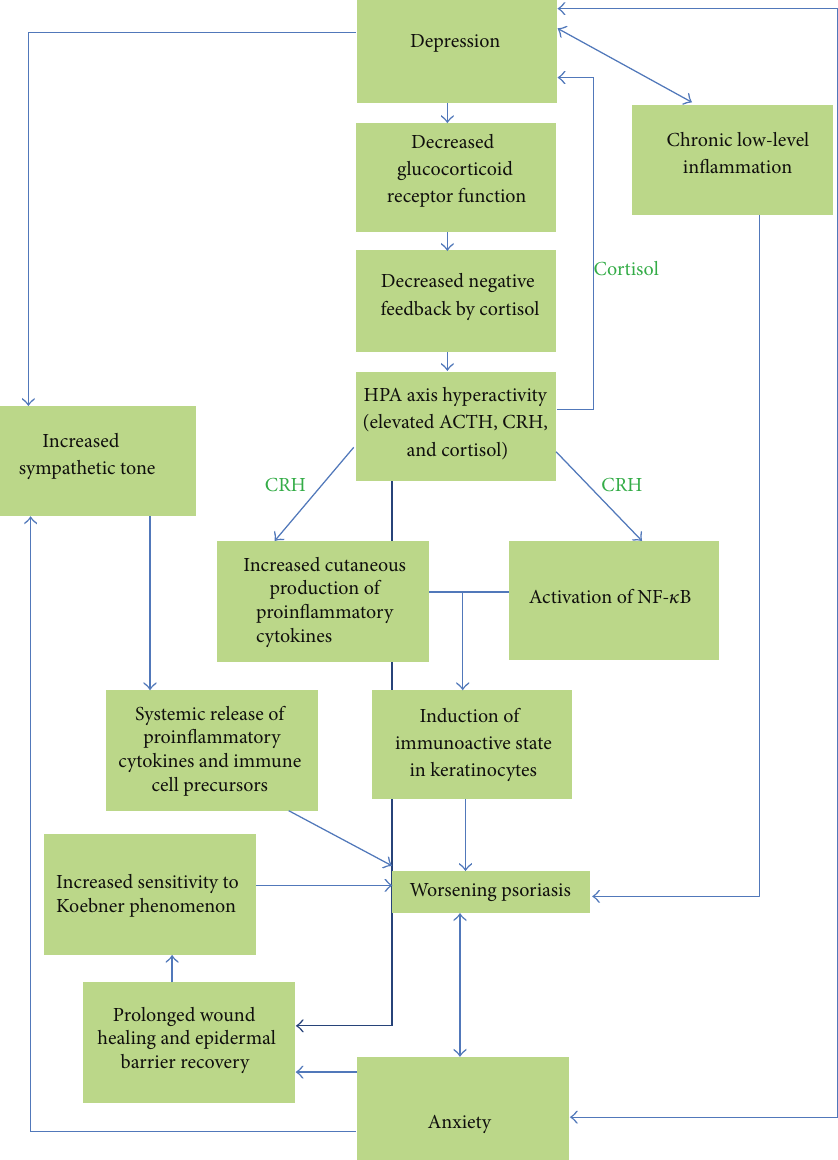
Figure 1: Overview: psoriasis and mood disorders. Depression and anxiety interact with psoriasis through associations with HPA axis hyperactivity, sympathetic hyperactivity, chronic inflammation, and delayed wound healing.